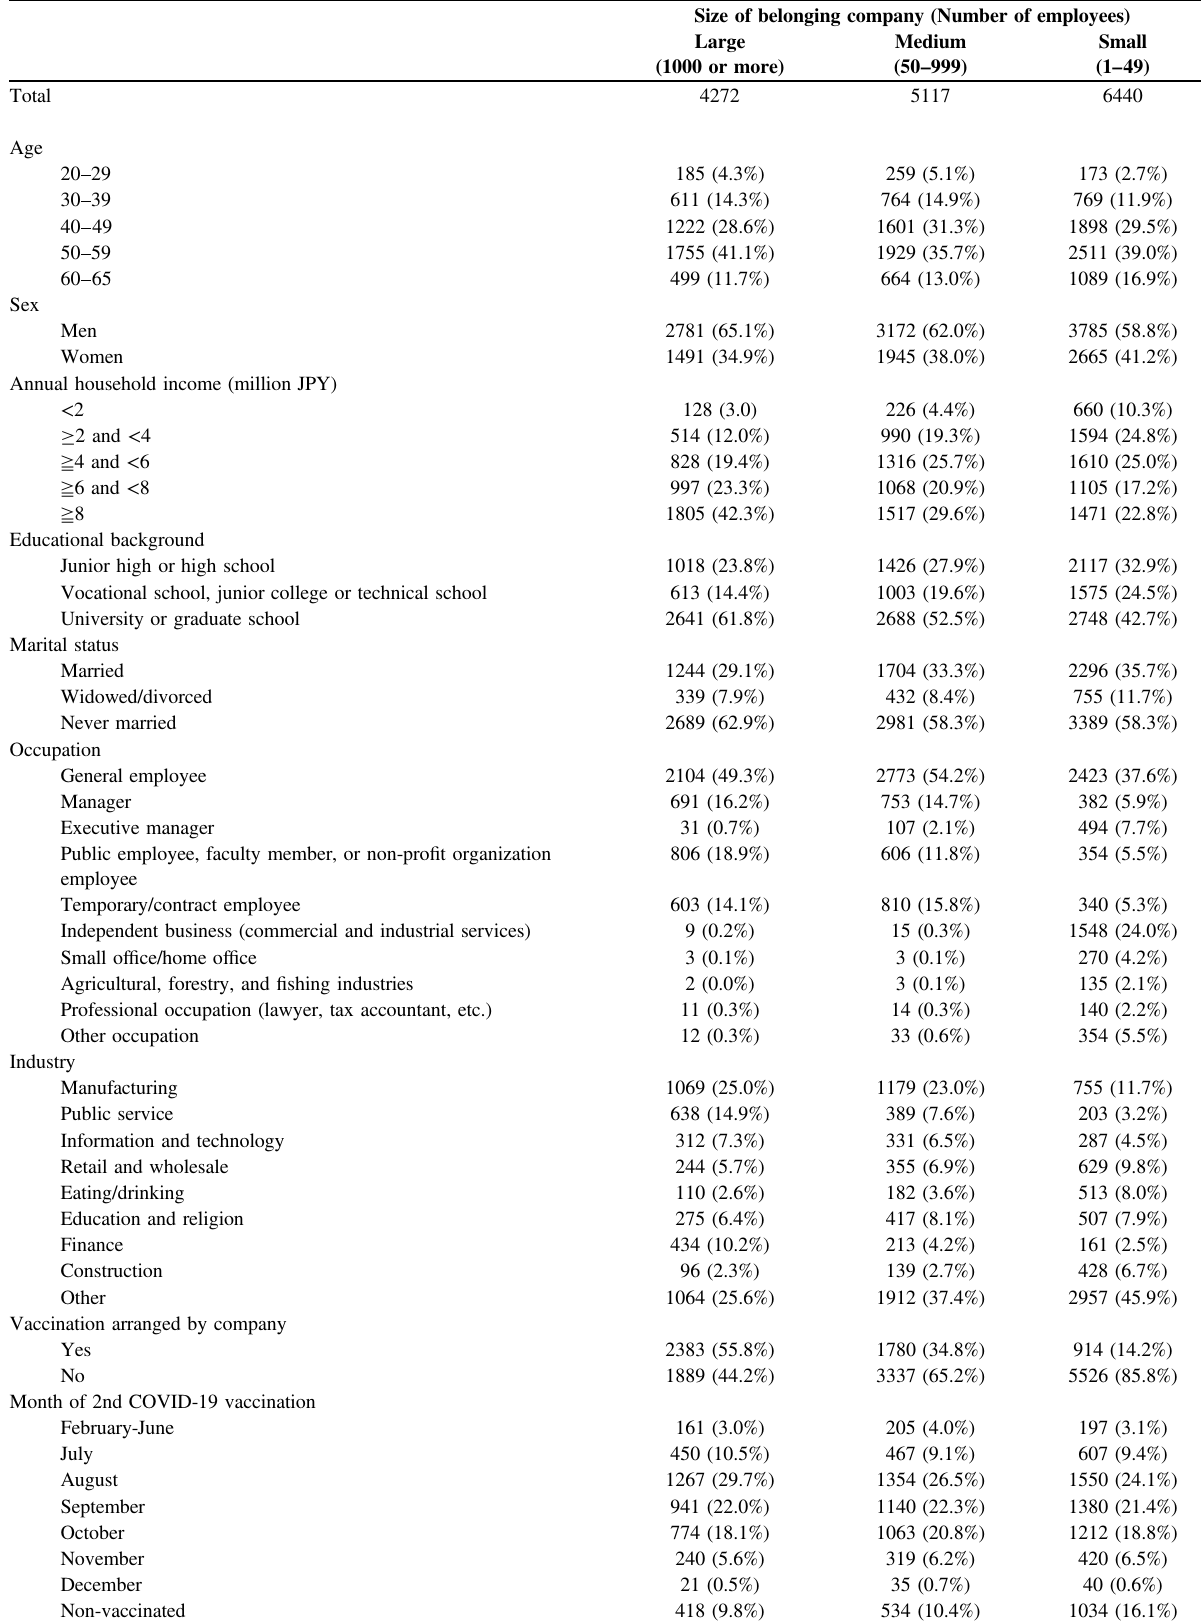
Table 1 Participant characteristics according to company